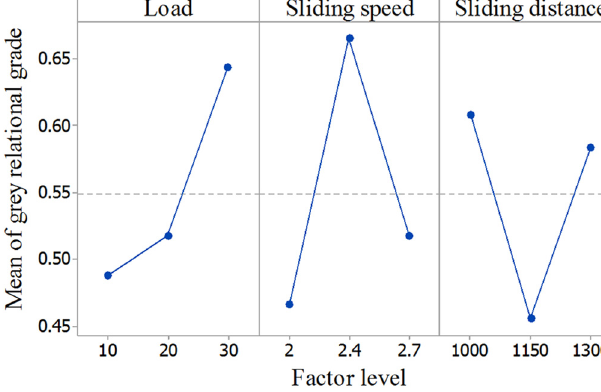
Fig. 2. Effect of grey relational grade.